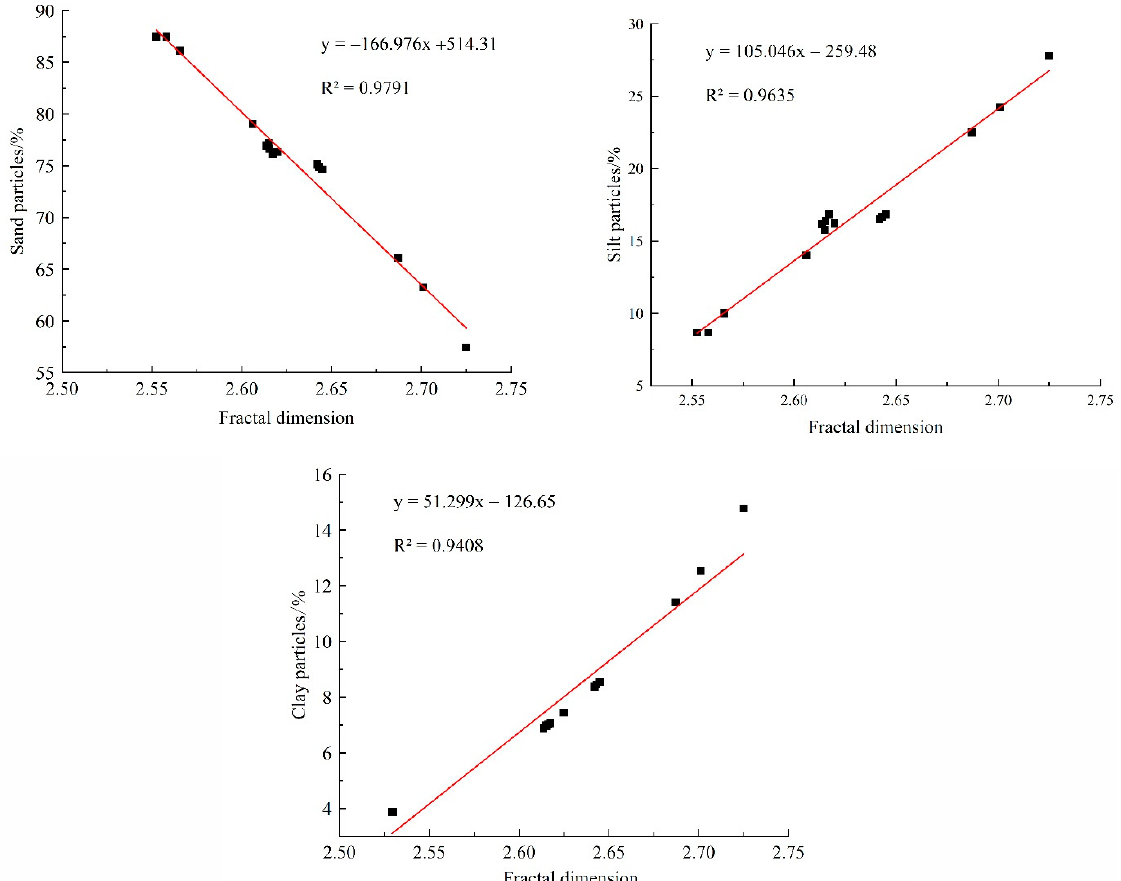
Figure 4. Relationship between soil fractal dimension and particle composition.